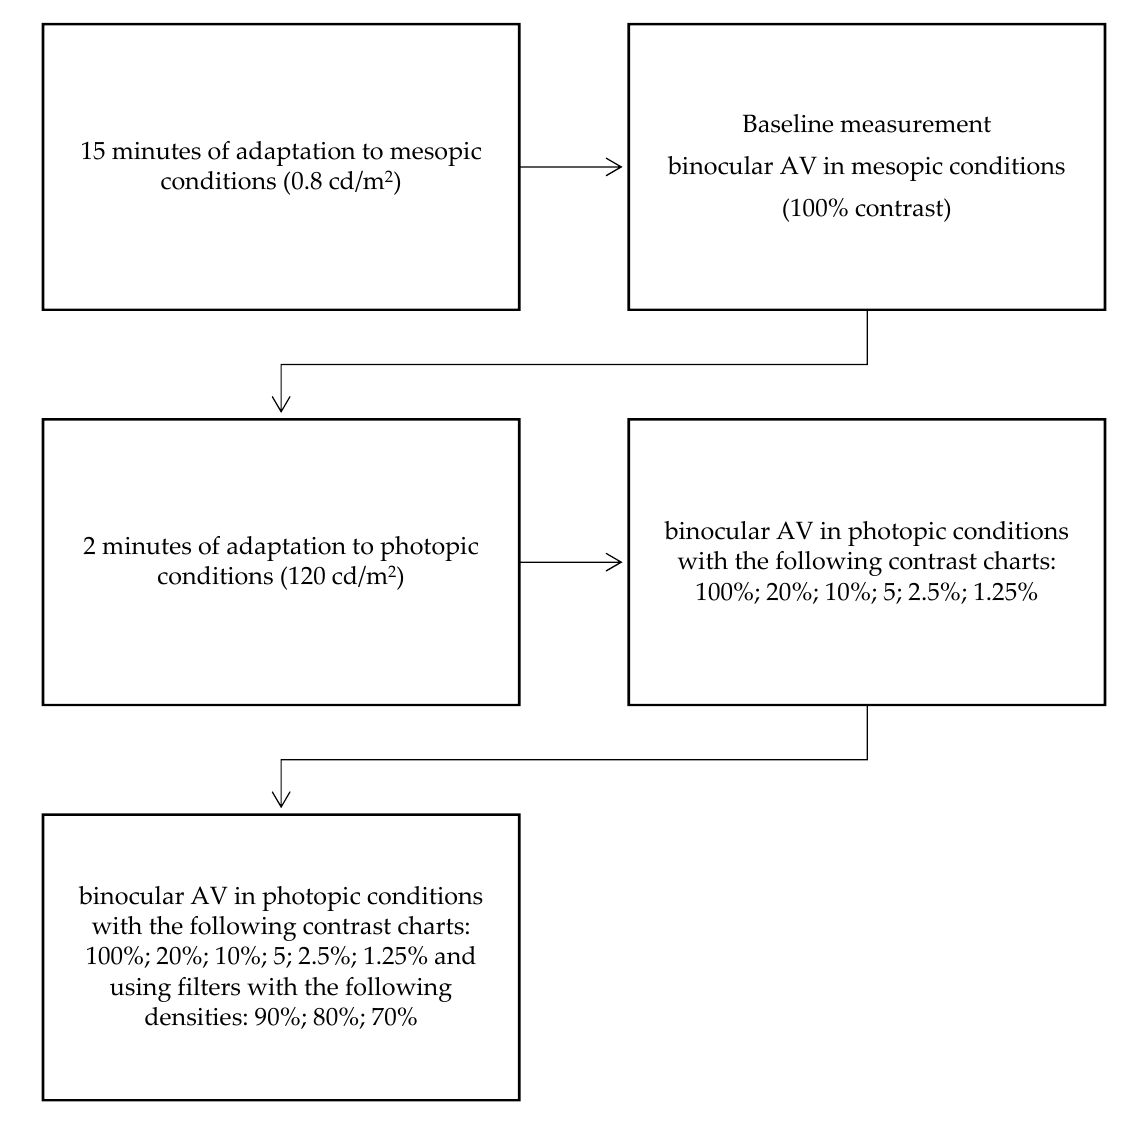
Figure 1. Flowchart of the visual examination steps.